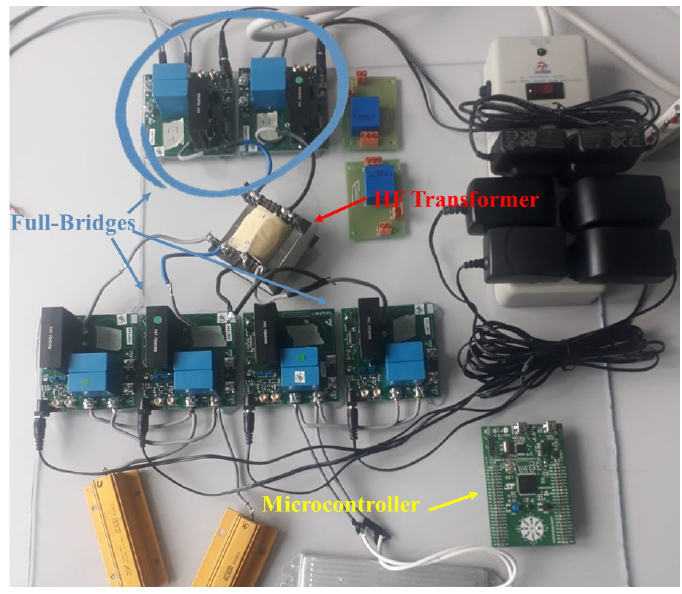
Figure 17. Test bench for early experimental results.